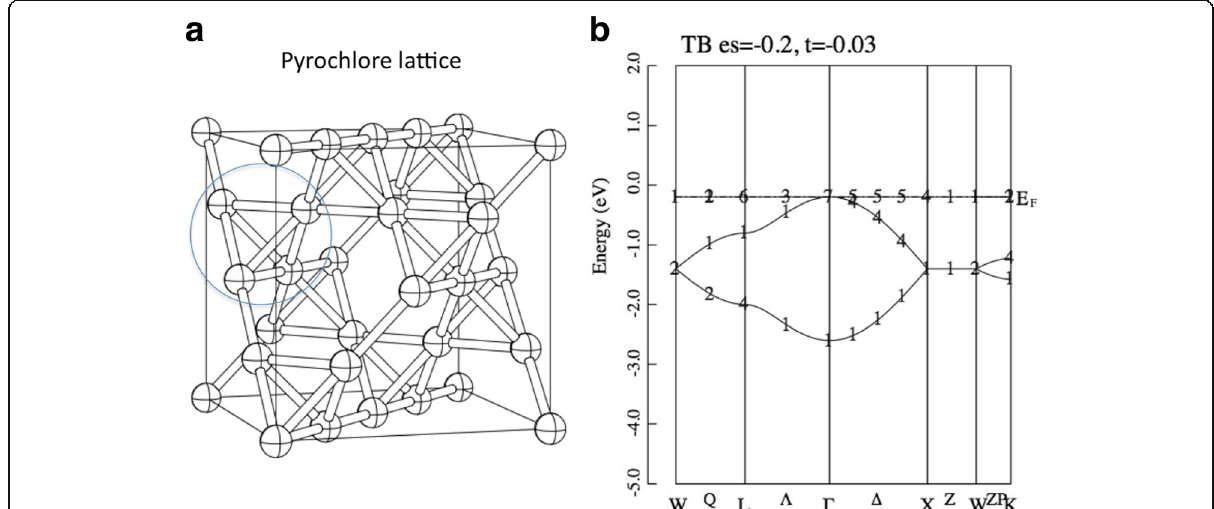
Fig. 1 a Pyrochlore lattice. The balls and sticks denote the sites and bonds, respectively. This is the A-site sublattice of A 2 B 2 O 7 pyrochlore structure. b Band dispersion of the tight-binding model (Eq. 1) on the pyrochlore lattice. The parameters are set as ε = − 0.2 and t = − 0.03. The unit of energy is eV. The number in ( b ) denotes the index of the irreducible representation, see ref.